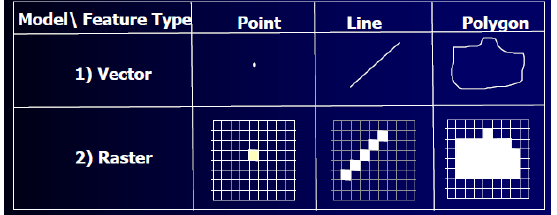
Figure 4: Comparison nature of vector and raster in point line and polygon shape/components.